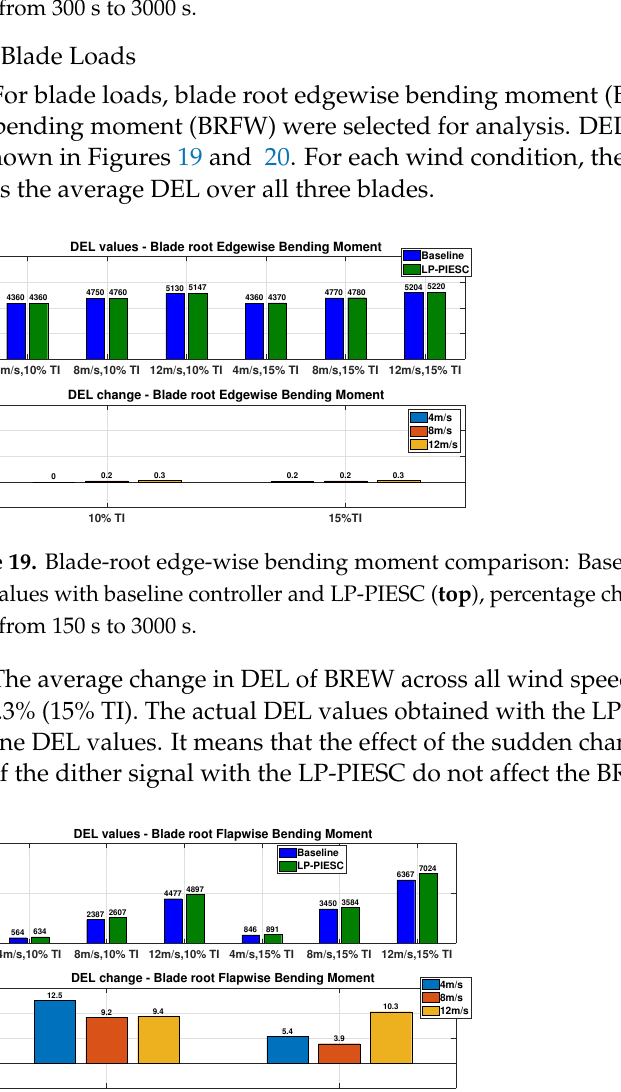
Figure 18. Tower-base side-side bending moment comparison: Baseline vs. LP-PIESC. Aggregate DEL values with baseline controller and LP-PIESC ( top ), percentage change in DEL ( bottom ) for time series from 300 s to 3000 s.